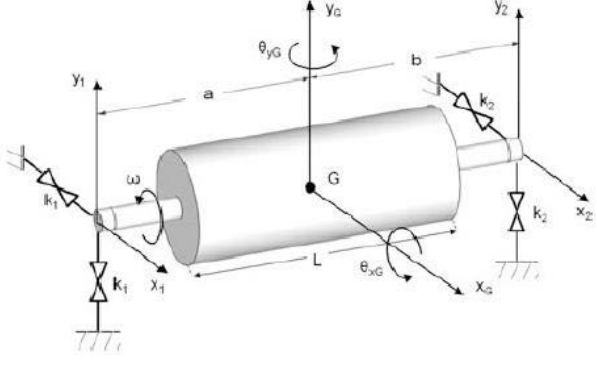
Figure 1. Cylindrical rotor with flexible